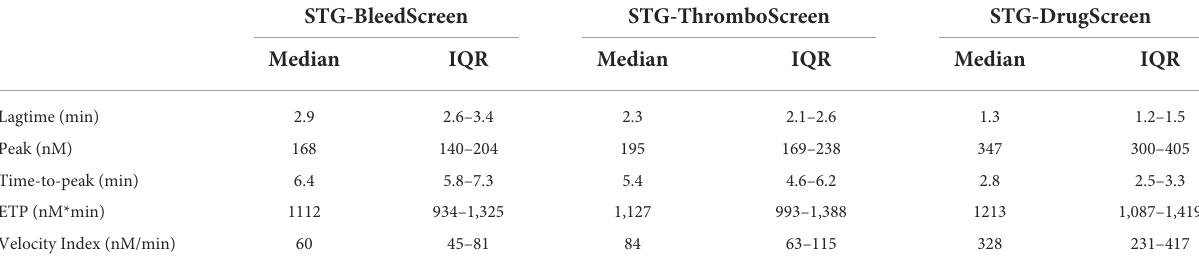
TABLE 1 Thrombin generation